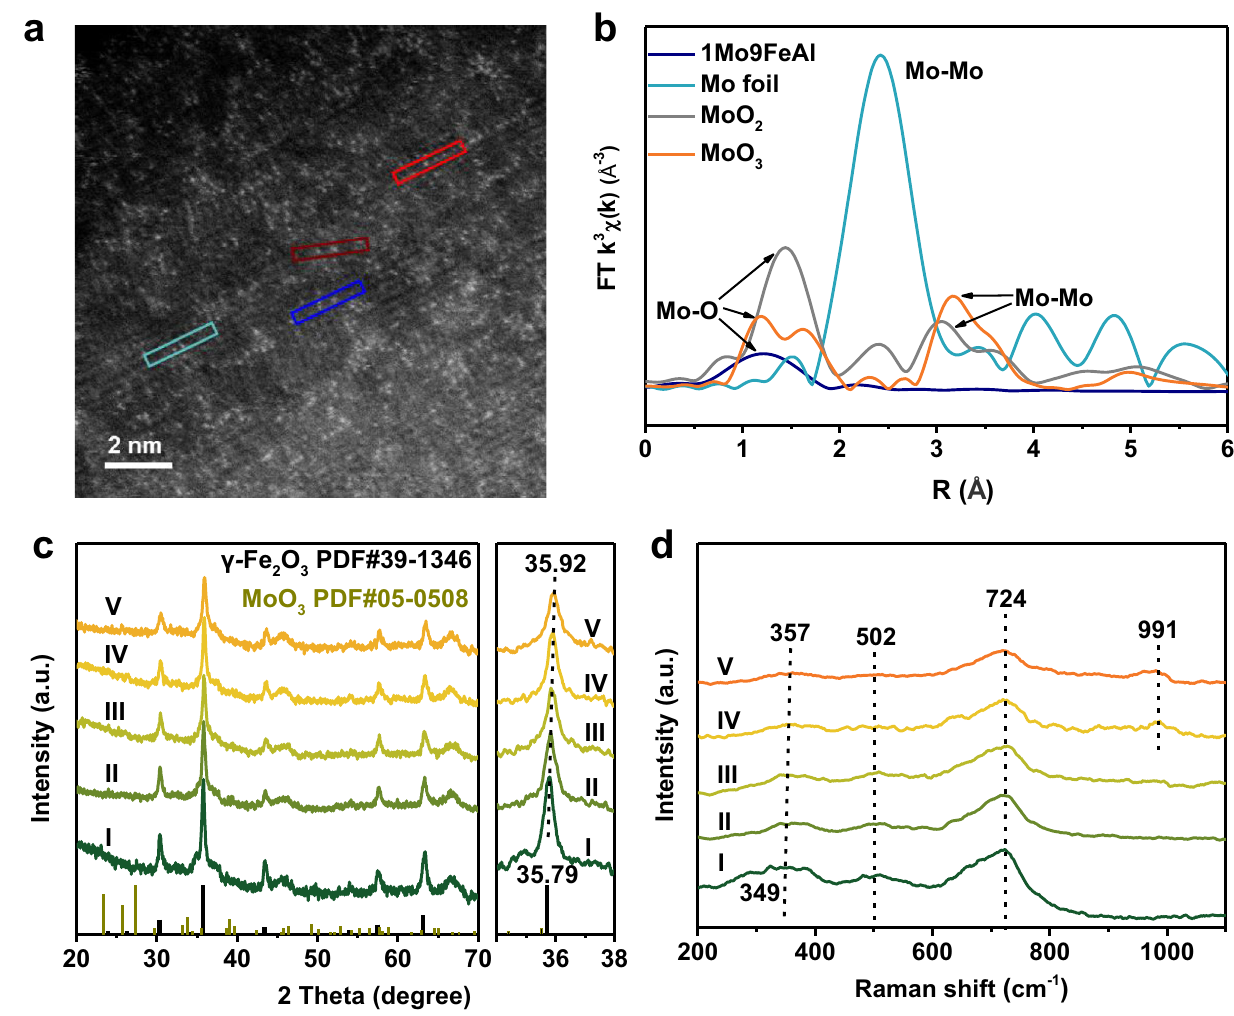
Fig. 2 | Morphology and textural properties of MoO 3 -Fe 2 O 3 redox catalysts. ( a ) AC-HAADF-STEM image of 1Mo9FeAl. ( b ) EXAFS spectra at Mo K-edge for 1Mo9FeAl, Mo foil, MoO 2 , and MoO 3 . XRD patterns ( c ) and Raman spectra ( d )